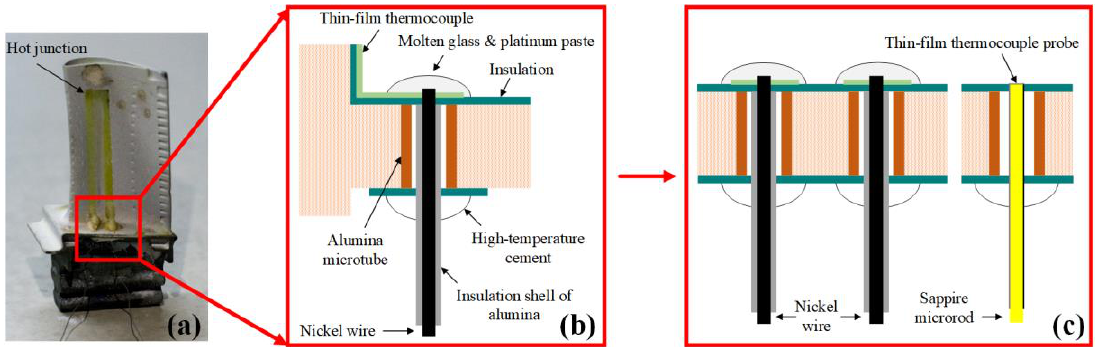
Figure 1. ( a ) Turbine blade with indium tin oxide (ITO) thin-film thermocouple, ( b ) structural diagram of the turbine blade through-hole lead connection, and ( c ) thin-film thermocouple probe used to measure the surface temperature.